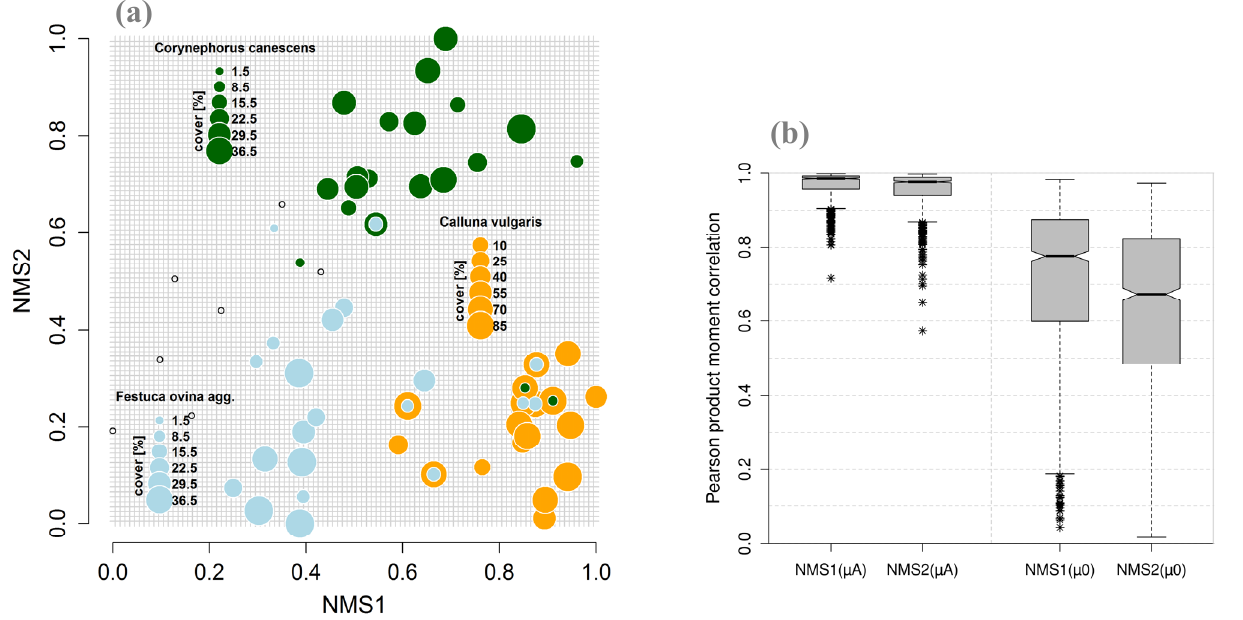
Figure 3. ( a ) Reference ordination space for open dryland habitats within the study area. Ordination scores were standardized between 0 and 1; point size is positively correlated to species cover of major indicator species. Green = Corynephorus canescens ; blue = Festuca ovina agg. ; orange = Calluna vulgaris . ( b ) Boxplot for 1000 bootstrapped correlations (µA) and for 1000 randomly permuted correlations (µ0) for ordination axes scores NMS1 and